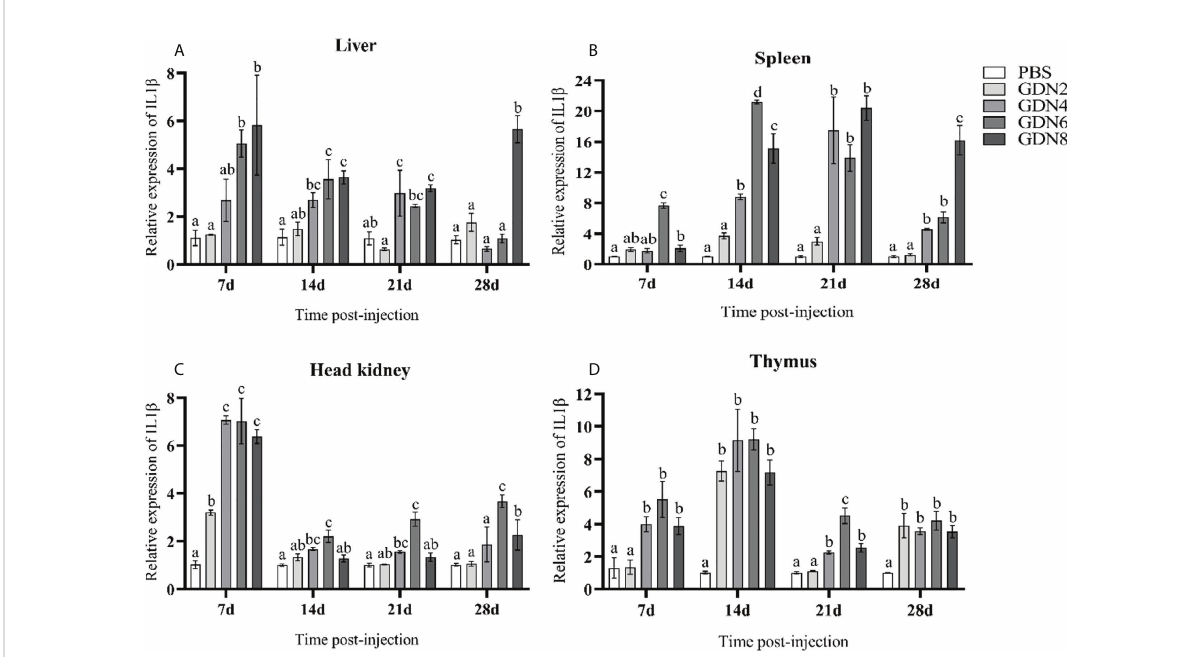
FIGURE 5 Expression levels of the MHC2 gene in the four tissues of pearl gentian grouper ( A , liver; B , spleen; C , head kidney; D , thymus) by qRT-PCR post-injection. The mRNA levels of the MHC2 gene were normalized to those of b -actin, and the relative expression levels were calculated. Signi fi cant differences ( p < 0.05) are marked by different letters (a – d).